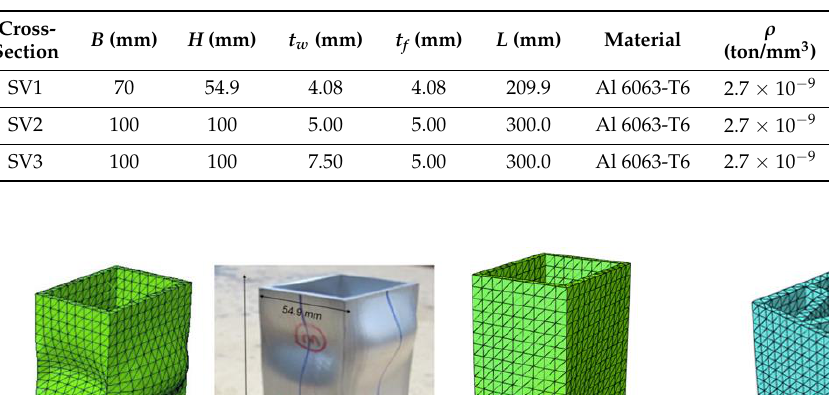
Table 1. Material properties and dimensions of each model.